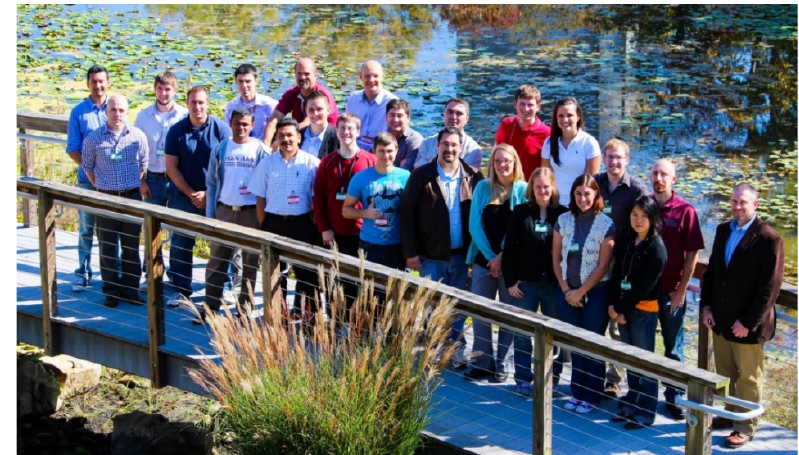
Figure 3. Students from Texas A&M, Penn State, and MIT at ORNL in fall of